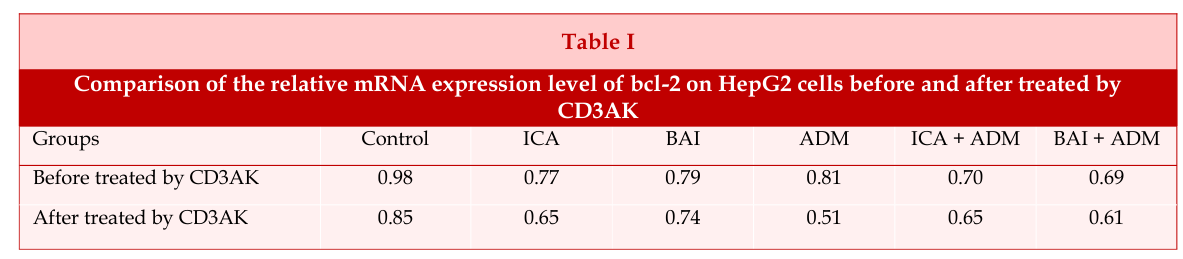
Figure 5: Effects of ICA, BAI, ADM on the sensitivity of HepG2 cells to CD3AK lysis; n=3